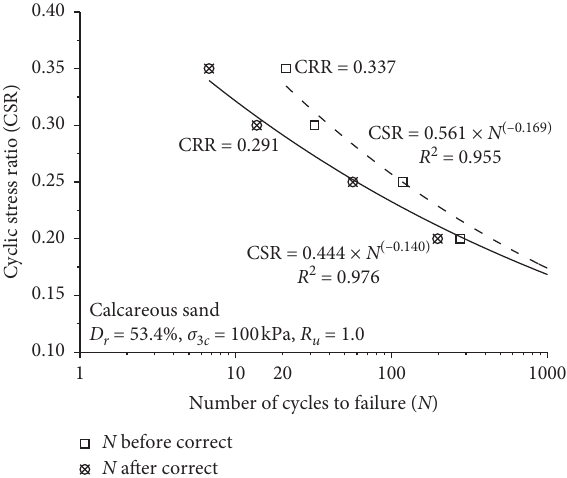
Figure 6: Cyclic strength curves of calcareous sand.